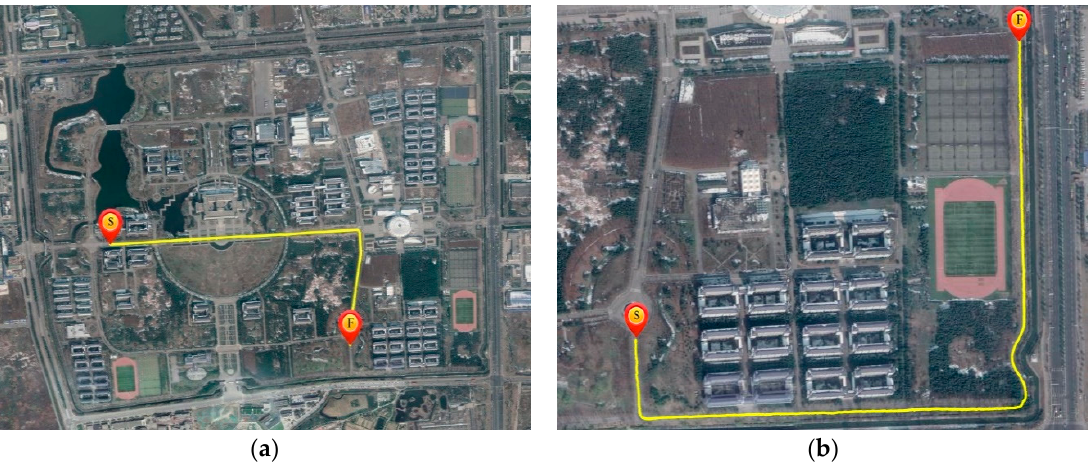
Figure 16. Experiment environment, ( a ) Open-sky condition, ( b ) Condition with roadside tree covering. Table 3. The RMSE of all methods in dynamic experiment. ( a ) Open-Sky Condition .